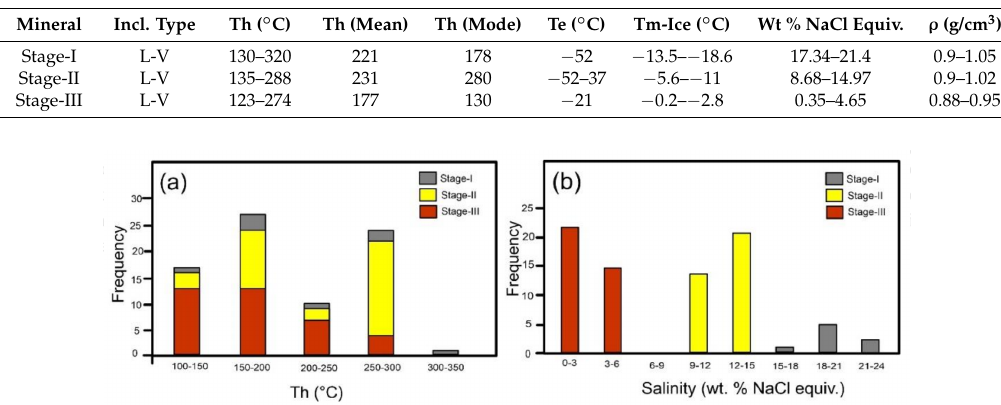
Figure 19. Histograms of ( a ) homogenization temperatures (Th) and ( b ) salinities of primary fluid inclusions in the sphalerite from the Shah-Ali-Beiglou deposit.